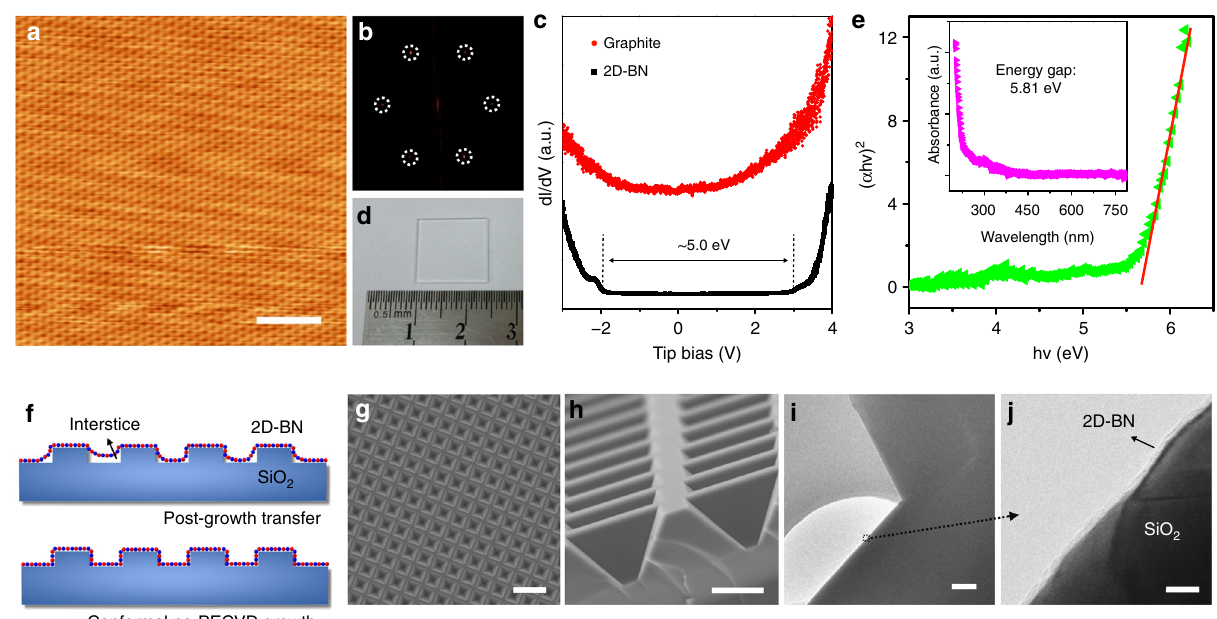
Fig. 2 Characterization of two-dimensional hexagonal-boron nitride (2D-BN). a Scanning tunneling microscopy image ( V Tip = − 0.5 V) and b fast Fourier transform (FFT) image of 2D-BN on highly oriented pyrolytic graphite (HOPG). The dashed circles highlight the points of the FFT pattern. c Scanning tunneling spectroscopy spectra collected from 2D-BN and HOPG (set point: V Tip = 3.0 V, I Tip = 48 pA). d Optical image and e Tauc plot (inset: ultraviolet spectrum) of 2D-BN grown on quartz. f Schematic illustration, g top view scanning electron microscope (SEM), h side view SEM, and i cross-section transmission electron microscope (TEM) image of 2D-BN grown by near-equilibrium plasma-enhanced chemical vapor deposition (ne-PECVD) on SiO 2 /Si with three-dimensional structures. j The higher magni fi ed TEM image of the areas indicated in i by a dashed frame. The scale bars are 2 nm in a , 10 μ m in g , 2 μ m in h , 200 nm in i , and 5 nm in